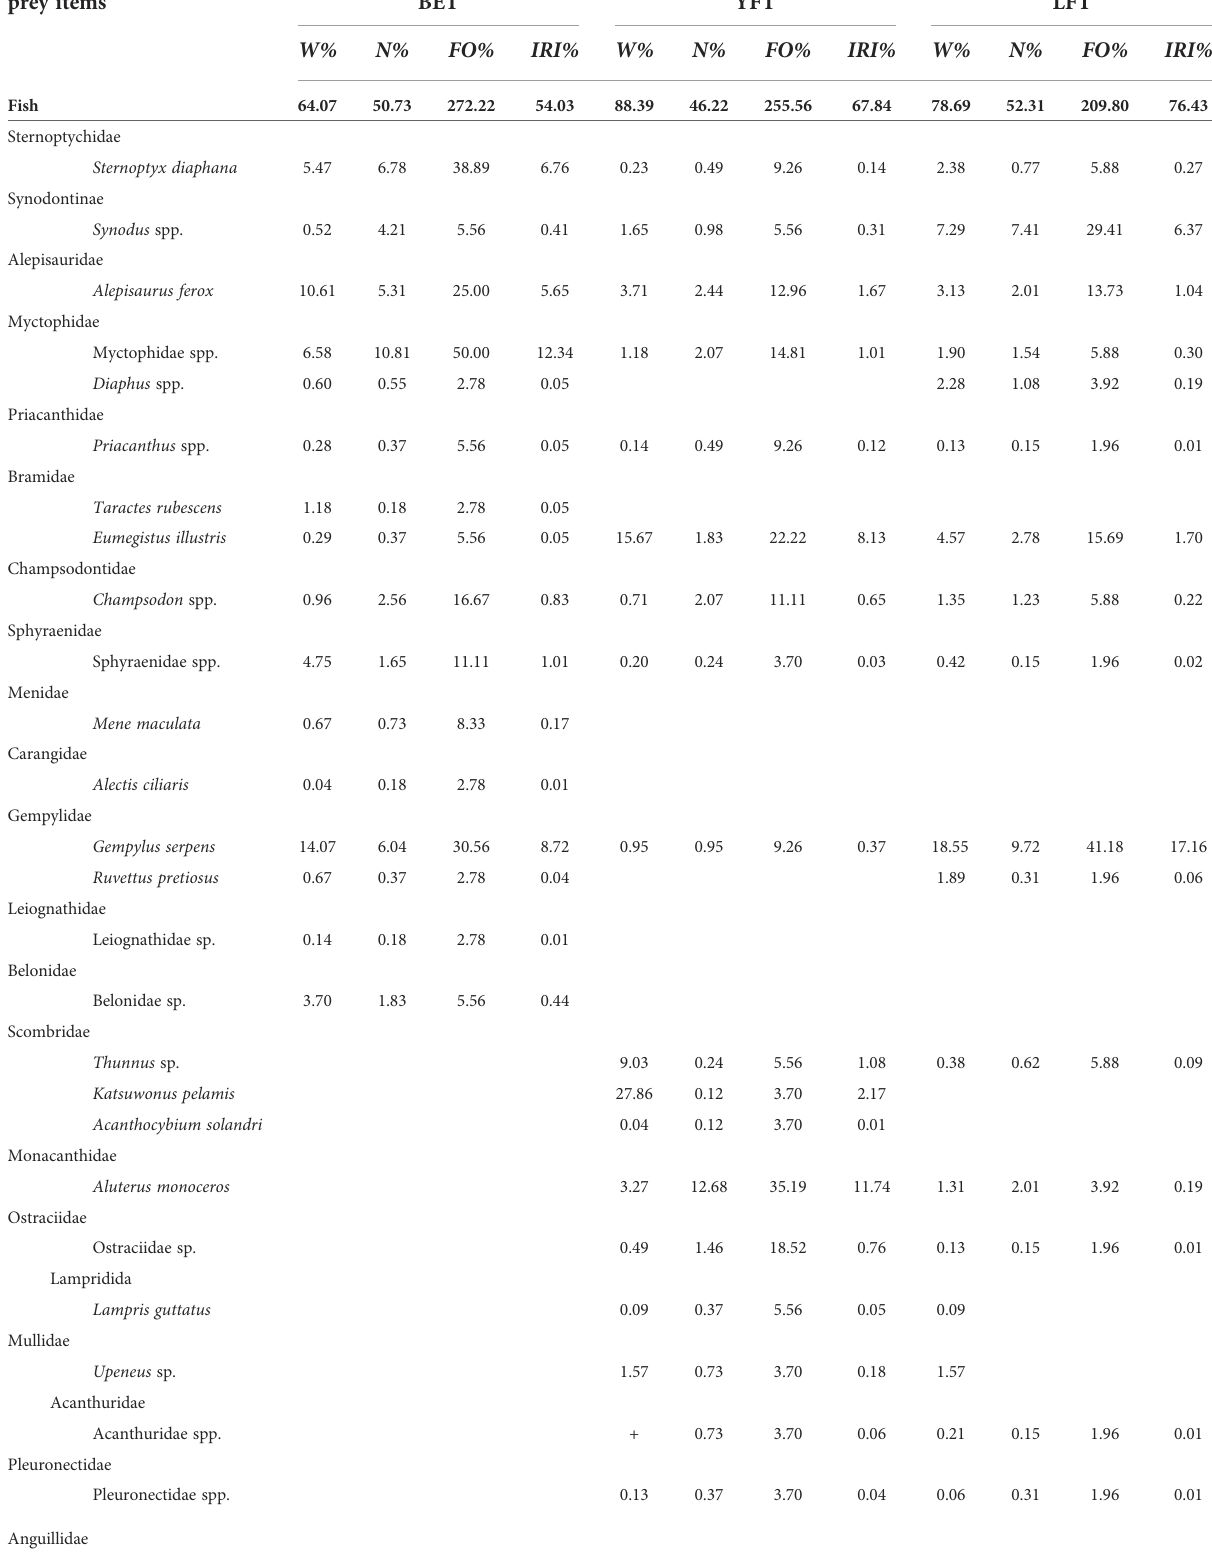
TABLE 2 Diet composition of three species of tuna. prey